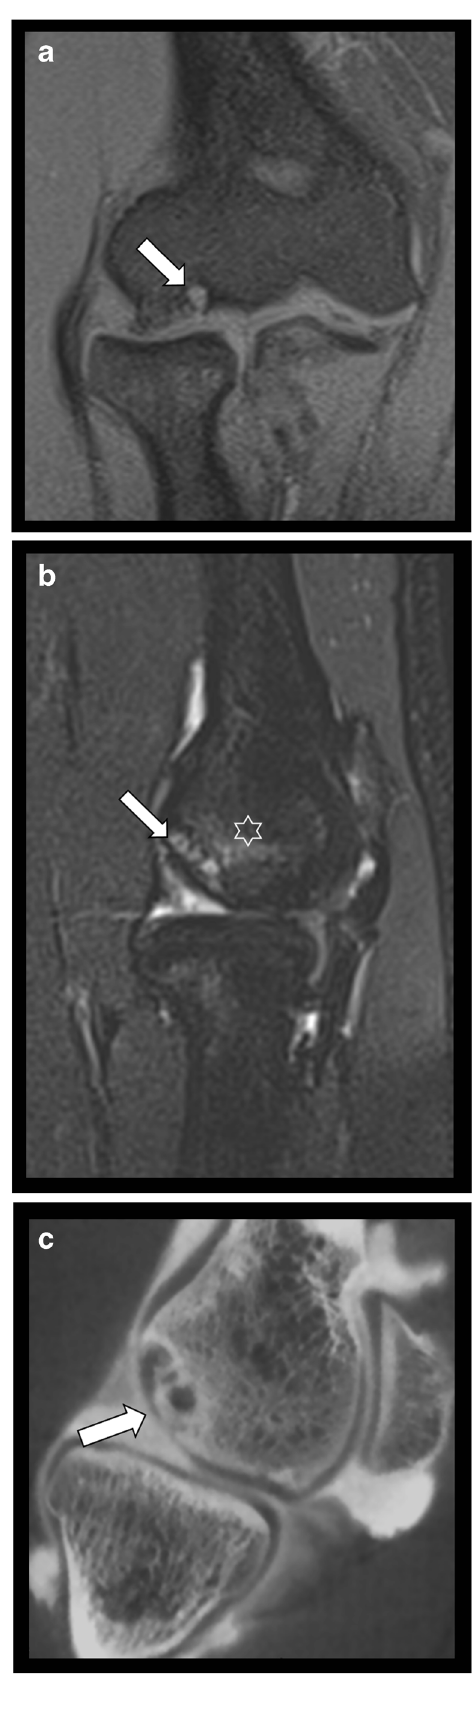
 Fig. 10 Osteochondral lesion of the capitulum. a . Coronal T1-WI fat saturated MR image showing a osteochondral lesion of the capitulum. b . Sagittal PD MRI fat saturated image at the level of radio-humeral joint revealing subchondral bone marrow changes (star) and subchondral cyst formation (arrow), the cartilage cannot be evaluated precisely. c . Sagittal reformatted CBCT-A at the level of the radio-humeral joint showing the osteochondral lesion of the capitulum with subchondral cyst formation, surrounding sclerosis and subtle focal thinning of the articular cartilage